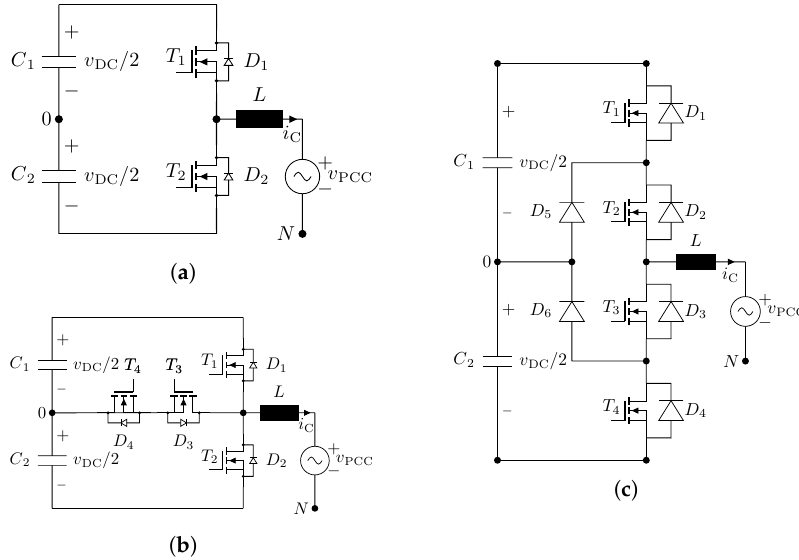
Figure 2. Schematics of conventional converter topologies. Just one leg of the three phase converter is shown in all cases. ( a ) Two-level (2L) topology. ( b ) Three-level neutral-point piloted (3L-TNPC) or 3L T-Type topology. ( c ) Three-level neutral-point-clamped (3L-NPC)